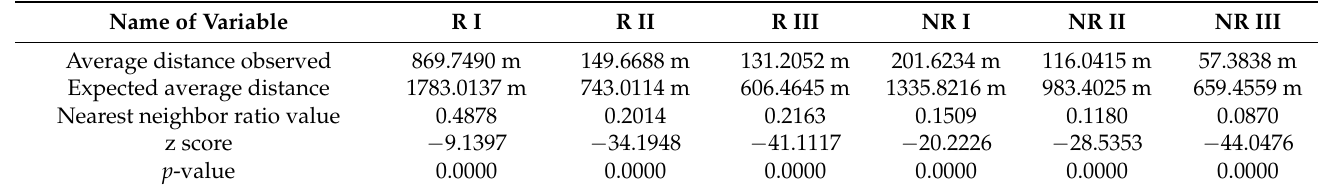
Table 1. The NNR index of the transmission locations of COVID-19 in different waves (RI stands for residential location transmission in stage I, RII stands for residential location transmission in stage II, RIII stands for residential location transmission in stage III, NRI stands for non-residential location transmission in stage I, NRII stands for non-residential location transmission in stage II, and NRIII stands for non-residential location transmission in stage III).